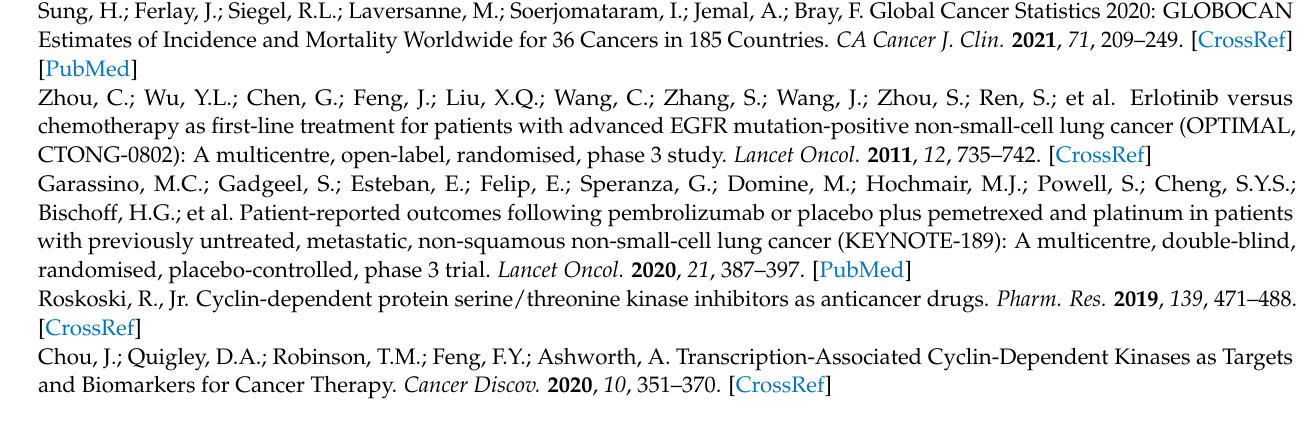
Table S2: Basic information of patients used to verify the expression levels of CDK1 and LINC00261. Table S3: Basic information of patients used to measure IL